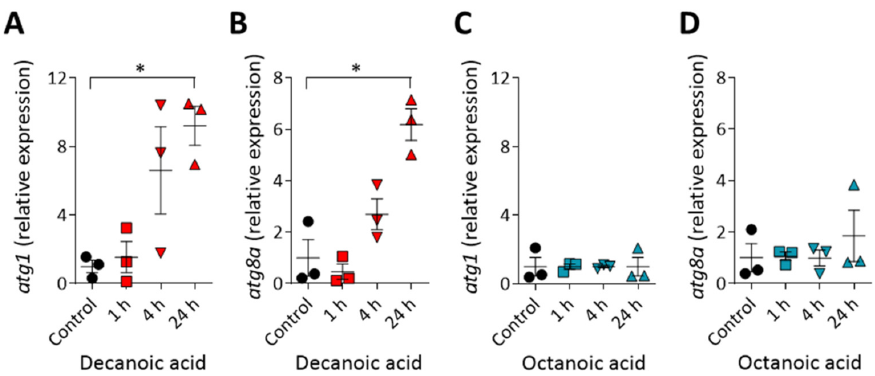
Figure 5. Decanoic acid but not octanoic acid increases autophagy gene expression after 24 h. Cells treated with decanoic acid (60 μ M) (or control) were analyzed by RT-qPCR measuring the relative abundance of ( A ) atg1 and ( B ) atg8a . Cells treated with octanoic acid (120 μ M) (or control) were also analyzed by RT-qPCR measuring the relative abundance of ( C ) atg1 and ( D ) atg8a . mRNA was normalized to the housekeeping gene gapdh in all conditions with the mRNA levels normalized so that untreated cells have a relative expression level of 1 ( n = 3). Data represented are mean ± SEM (Kruskal–Wallis with Dunn’s multiple comparisons test). Significance is indicated by * p ≤ 0.05.